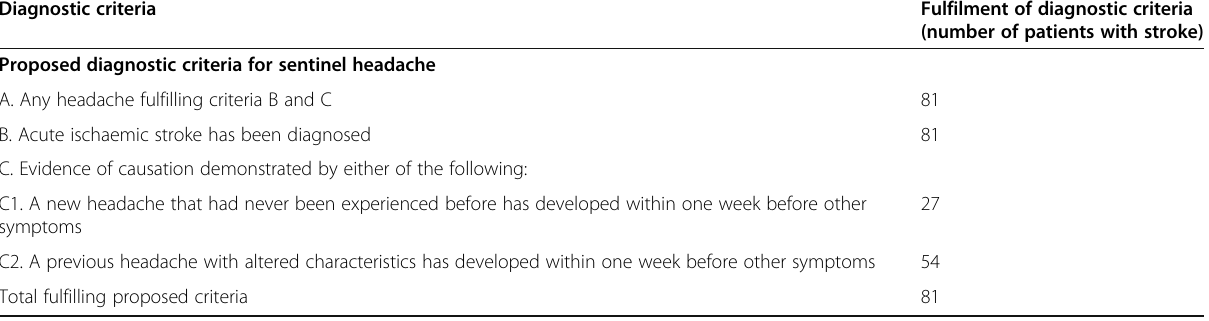
Table 8 Fulfilment of proposed subcriteria for sentinel headache Diagnostic criteria